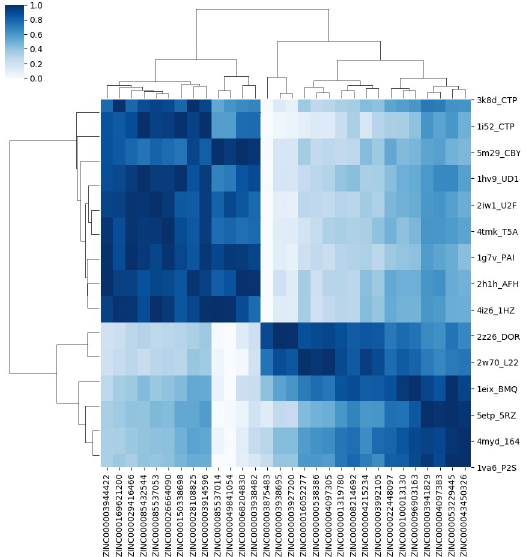
Fig 3. The heat map of selected ligands from the 1-percentile